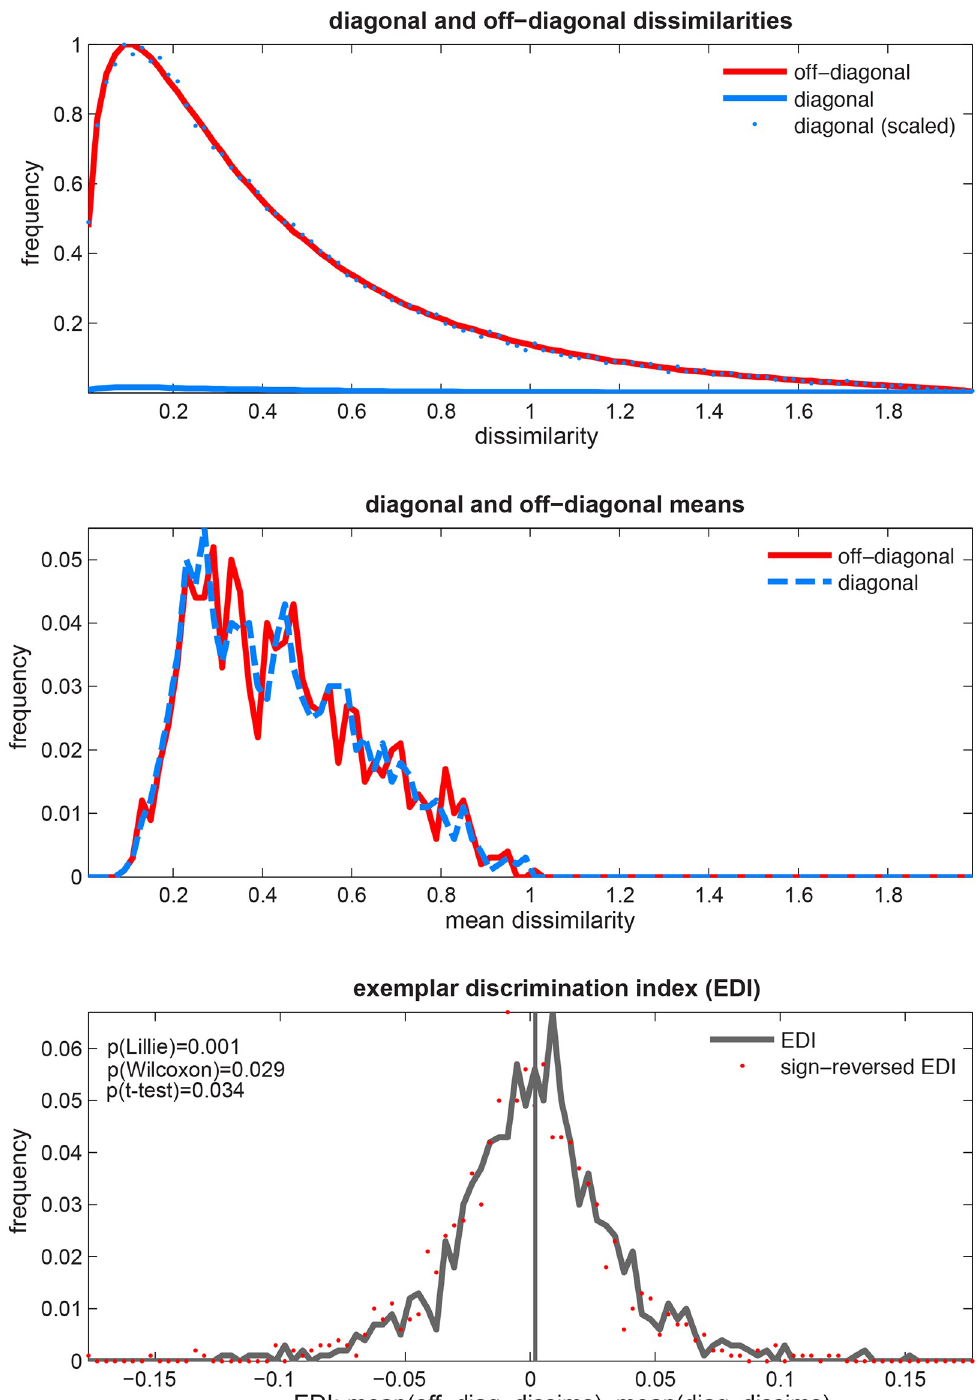
Fig 6. The EDI can be non-Gaussian under the null hypothesis (H 0 ). Top panel : The distribution of the diagonal (blue) and off-diagonal (red) dissimilarities. Distributions are obtained from the dissimilarities aggregated across pairs and simulated subjects. There are fewer diagonal entries but they are sampled from the same distribution as off-diagonal dissimilarities under the null hypothesis. Therefore the two distributions differ only by a scaling factor. Middle panel : The distribution of the diagonal and off-diagonal average dissimilarities. Data were simulated for each subject (1,000 in total) and the distributions were obtained by pooling the averages across all subjects. Bottom panel : The EDI distribution in this